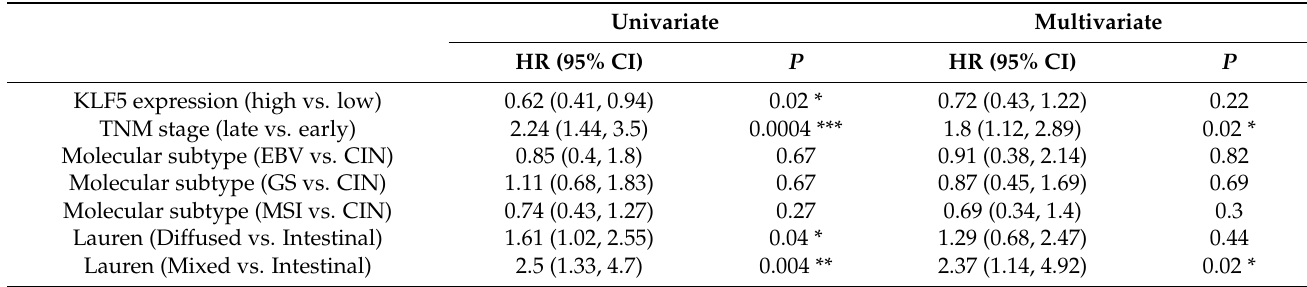
Table 2. Cox proportional hazards regression model analysis for overall